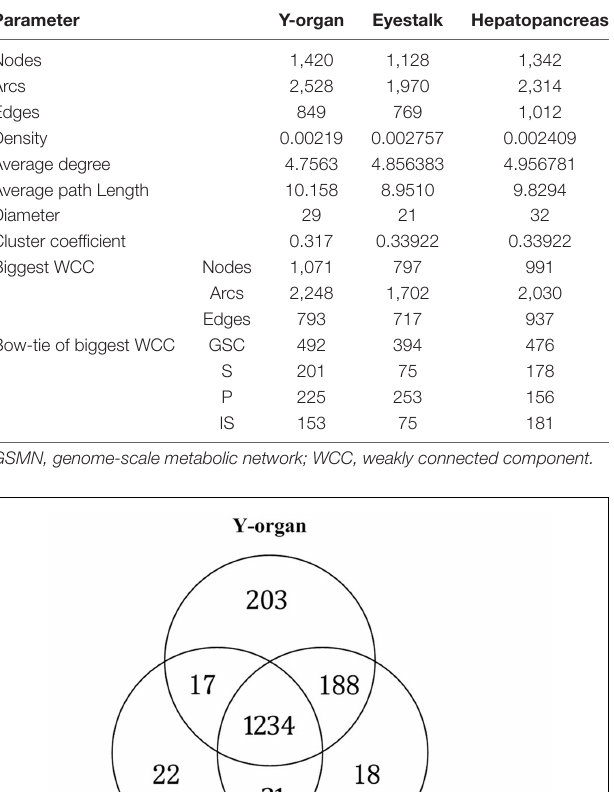
TABLE 8 | Topological features of Y-organ, eyestalk, and hepatopancreas GSMNs.